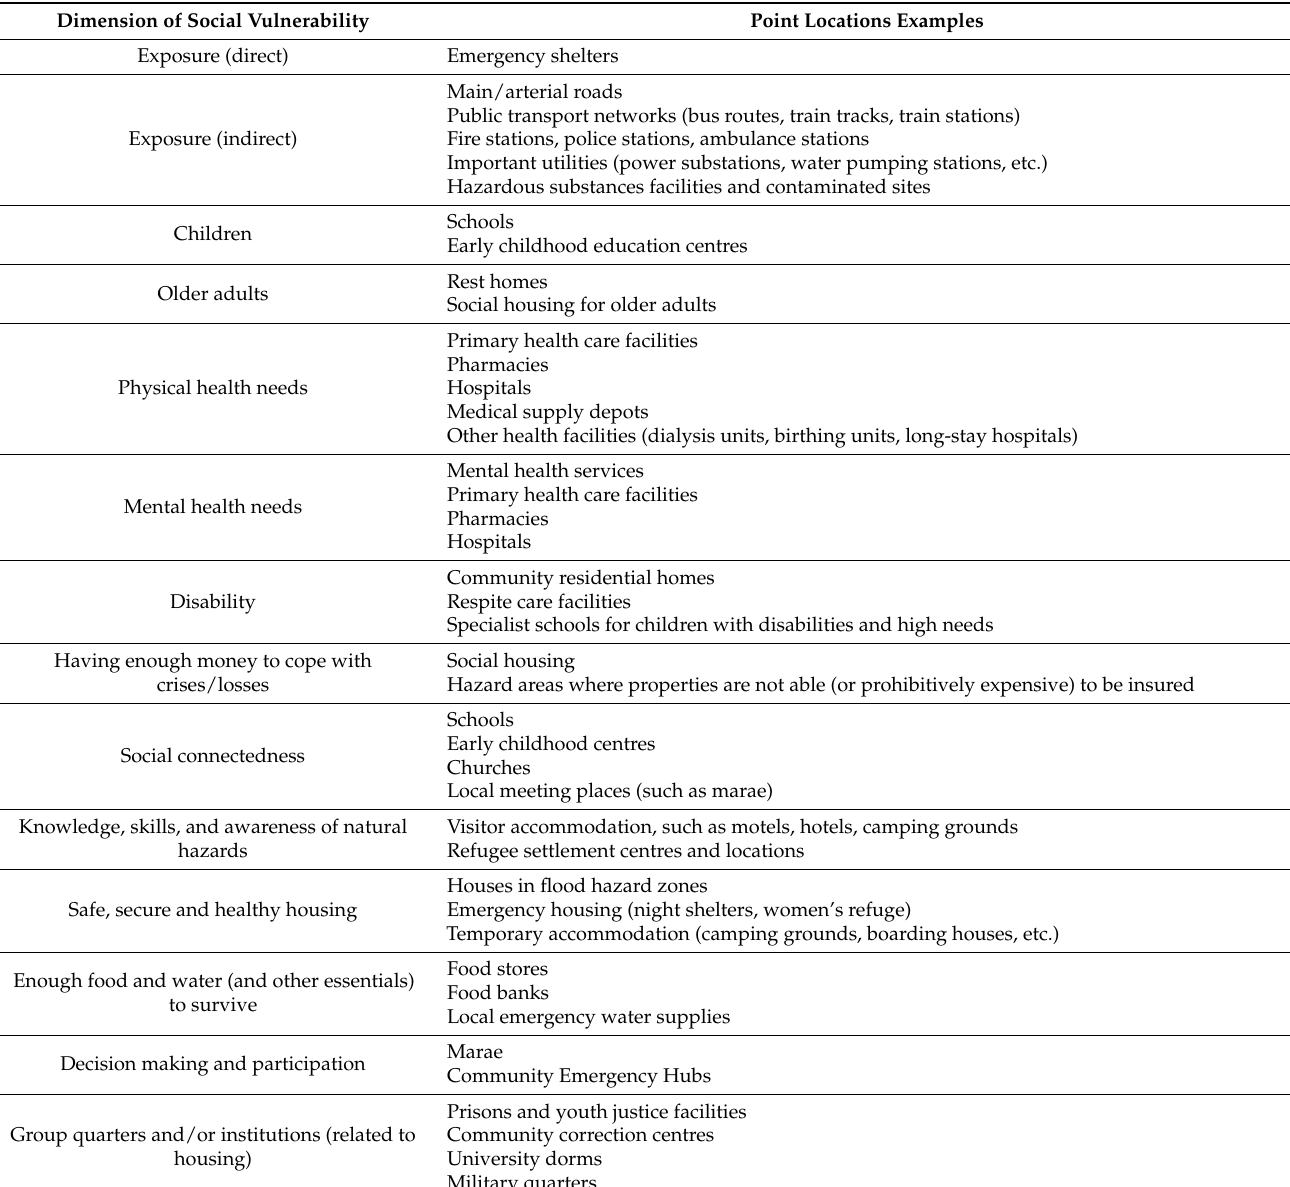
Table A4. Point locations relating to social vulnerability for flooding for New